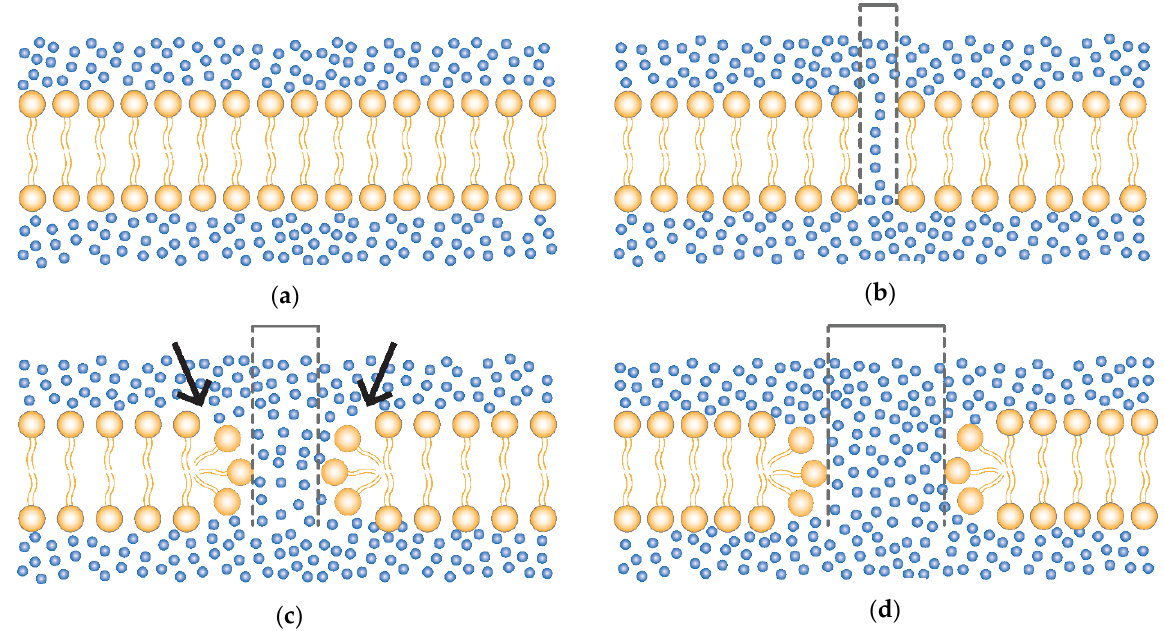
Figure 1. Formation of membrane pores. ( a ) Normal non-electroporated phospholipid bilayer membrane (yellow) and water (blue dots). ( b ) Early formation of a small unstable water channels. ( c ) Reorganization of the hydrophilic heads (arrow) and consequent formation of a metastable pore (reversible electroporation); with pulse cessation the membrane tends to return to the normal state ( a ); and ( d ) electric pulses beyond the RE threshold parameters leads to enlargement and destabilization of the pore with consequent loss of cell homeostasis (irreversible electroporation—IRE). Dashed lines representing the pore size.